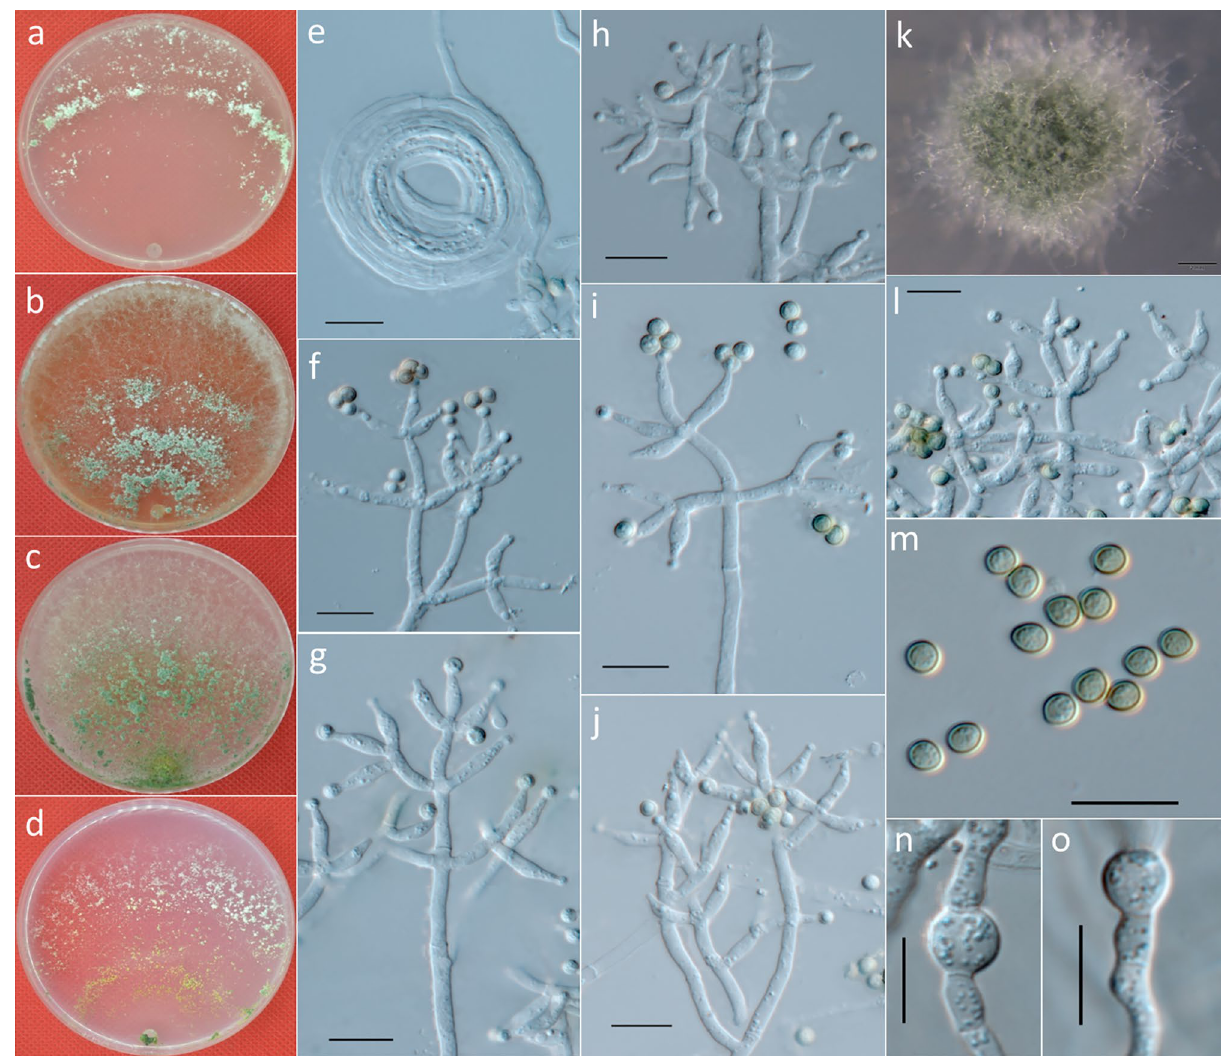
Figure 6. Cultures and asexual morph of Trichoderma alni . ( a – d ). Cultures after 7 days at 25 °C [( a ) on CMD; ( b ) on MEA; ( c ) on PDA; and ( d ) on SNA]. € Coilings of aerial hyphae (PDA, 6 days). ( f – j , l ). Conidiophores and phialides (CMD, 5–7 days). ( k ) Conidiation tuft (PDA, 7 days). ( m ) Conidia (CMD, 6 days). ( n , o ) Chlamydospores (PDA, 7 days). Scale bars: ( e – j,l – o ) = 10 μm; ( k ) = 2 (Fig. 7a). Aerial hyphae are abundant and radiating and form thick green downy, fluffy, or floccose mats (Fig. 7e). No diffusing pigment, but fragrant odor noted. Conidiophores are pyramidal with opposing branches, with each branch terminating in a cruciate whorl of up to four or five phialides. Phialides are frequently solitary or in a whorl of three or four. Phialides are ampulliform to lageniform and often constricted below the tip to form (Fig. 7f–j). Conidia are subglobose to ovoid, 3–4.5 × 2.5–3.3 μm ( x = 3.5 ± 0.3 × 3 ± 0.2, n = 50), laurel-green to bright green, smooth, and ellipsoidal (Fig. 7k). On PDA, after 72 h, growth is 41–43 mm at 20 °C and 50–55 mm at 25 °C; and mycelium covers the plate after 5–6 days at 25 °C. Colonies show distinct zonation. Mycelia are dense, opaque, and thick; hyphae are wide and sinuous and often form strands on the margin (Fig. 7c). Margin is thick and ill defined. Aerial hyphae are abundant and radiating and form thick green downy, fluffy or floccose mats. Chlamydospores examined after 7 days are 5.5–9 × 5.5–9.0 μm ( x = 7 ± 0.8 × 7 ± 0.8, n = 30), globose to oval when terminal and smooth, showing an almost unobserved intercalary (Fig. 7l,m). On SNA, after 72 h, growth is 33–35 mm at 20 °C and 38–40 mm at 25 °C; and mycelium covers the plate after 7–8 days at 25 °C. Colonies show distinct zonation. Mycelia are thin and green; hyphae are narrow and sinuous and show indistinct strands on the margin (Fig. 7d). Margin is thin and ill defined. Aerial hyphae are slight and form a thick downy, fluffy, or floccose mat appearing in the colony. No diffusing pigment or distinct fragrant odor was noted. Conidiation was similar to CMD. Trichoderma polysporum Rifai, Mycol. Pap. 116: 18, 1969 (Fig. 8).